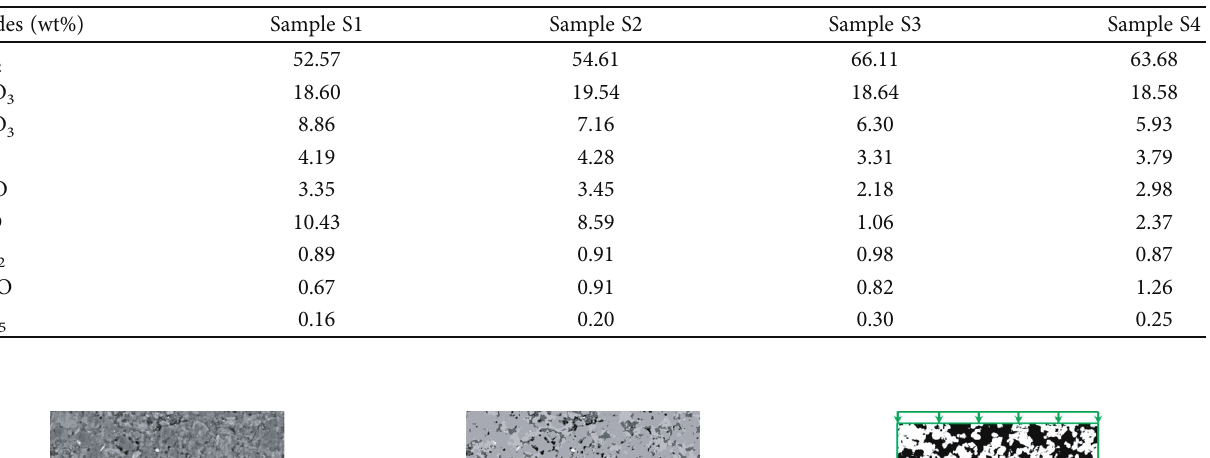
Table 1: Major chemical composition of the red mudstone samples.